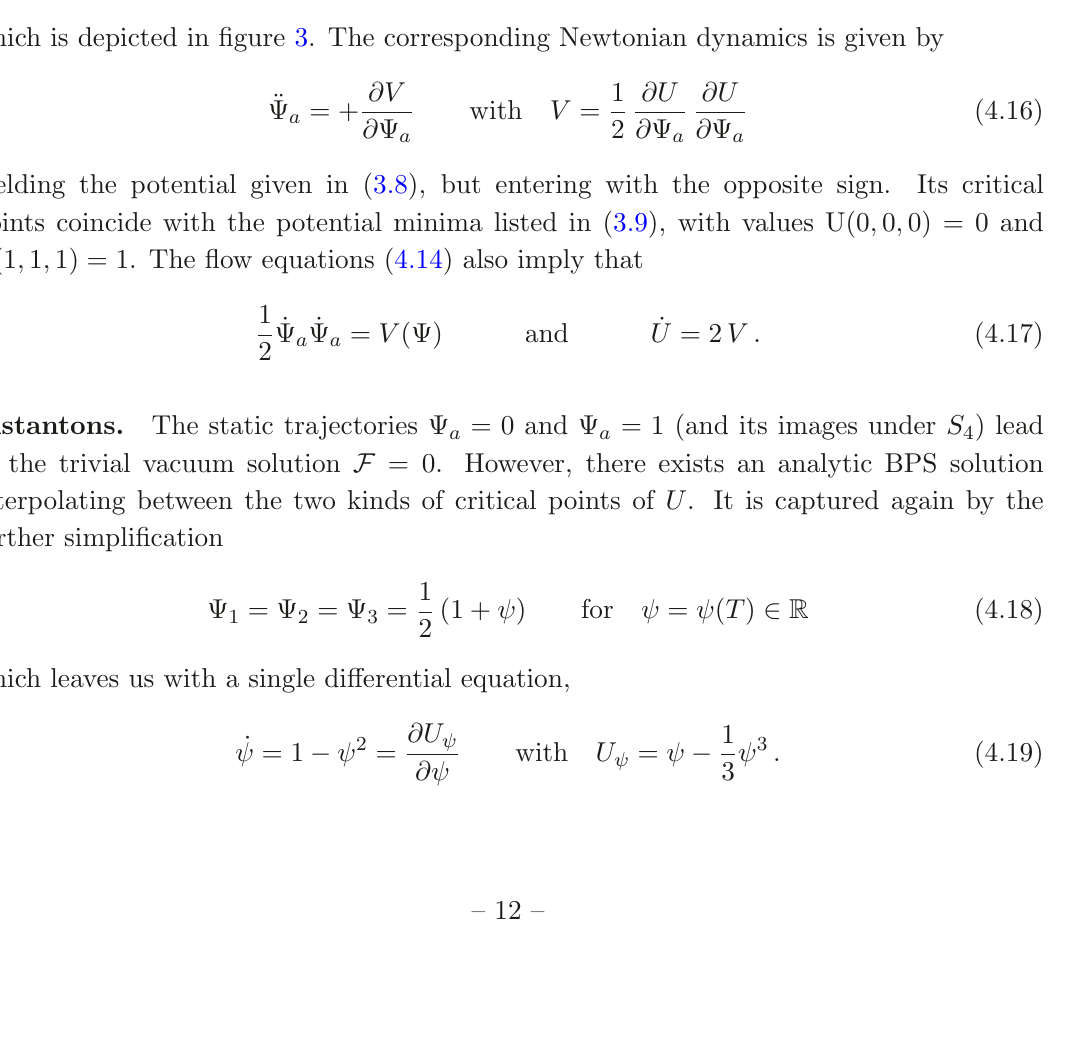
Figure 3 . Contours of the superpotential potential U in